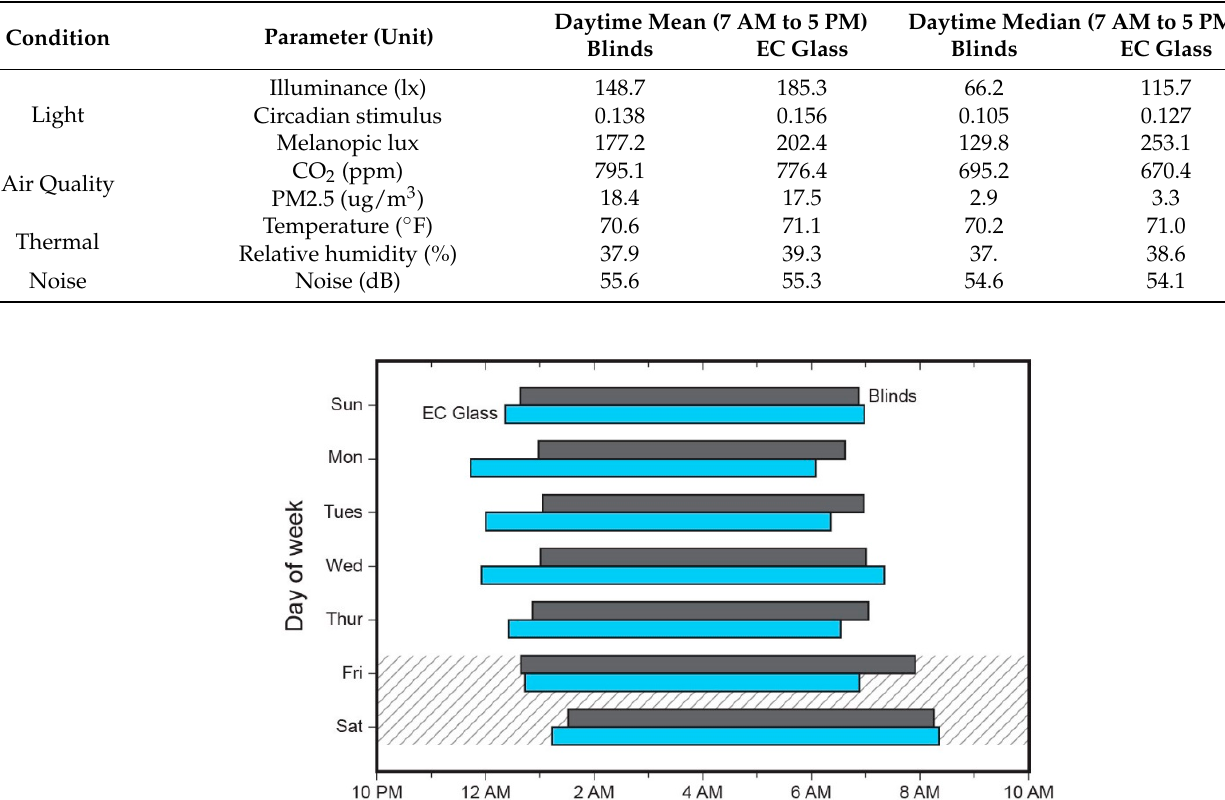
Table 2. Mean and median daytime environmental conditions across study conditions. All values reflect daytime means or medians, as defined by sunrise (6:56 AM) to sunset (4:52 PM). Air quality, thermal conditions, noise levels, and illuminance were collected by the Awair Omni devices located on the wall of the living room. Daytime circadian stimulus was collected at participant chest-level using Daysimeter devices and spectrally weighted melanopic lux was derived from calibrated Daysimeter RGB sensor data.